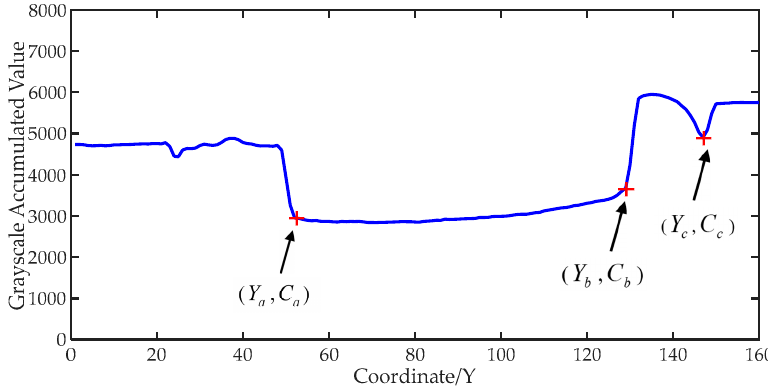
Figure 4. The graph of image accumulated grayscale value.